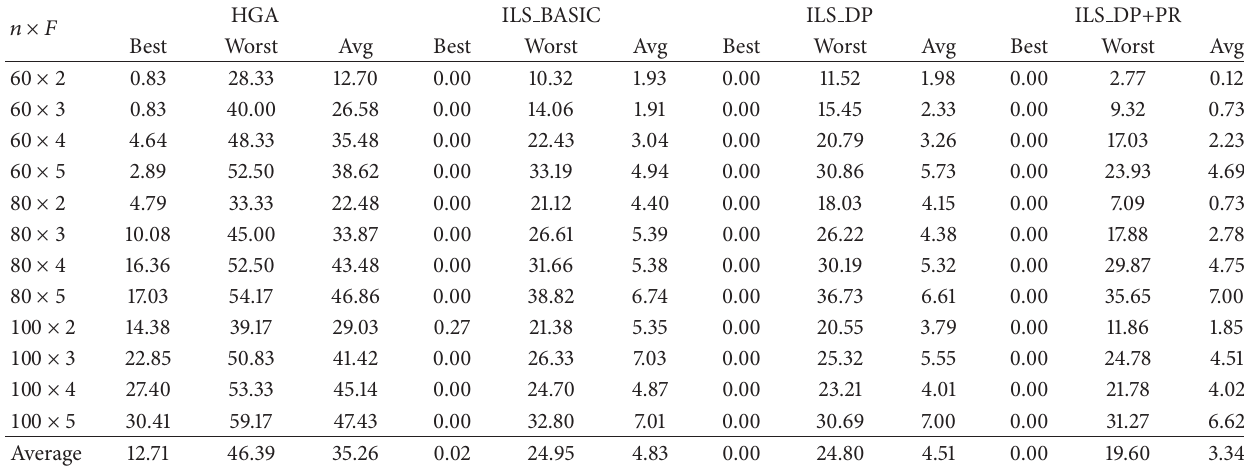
Table 4: Average RDIs (%) of the heuristics on large size instances.